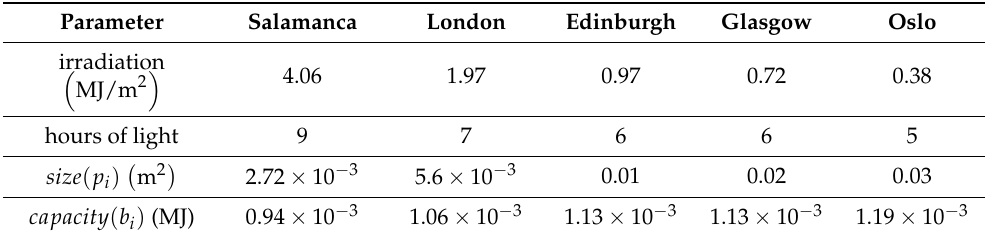
Table 8. Solar panel size and battery capacity to satisfy the daily device load based on the irradiation level and the hours of light in the city of